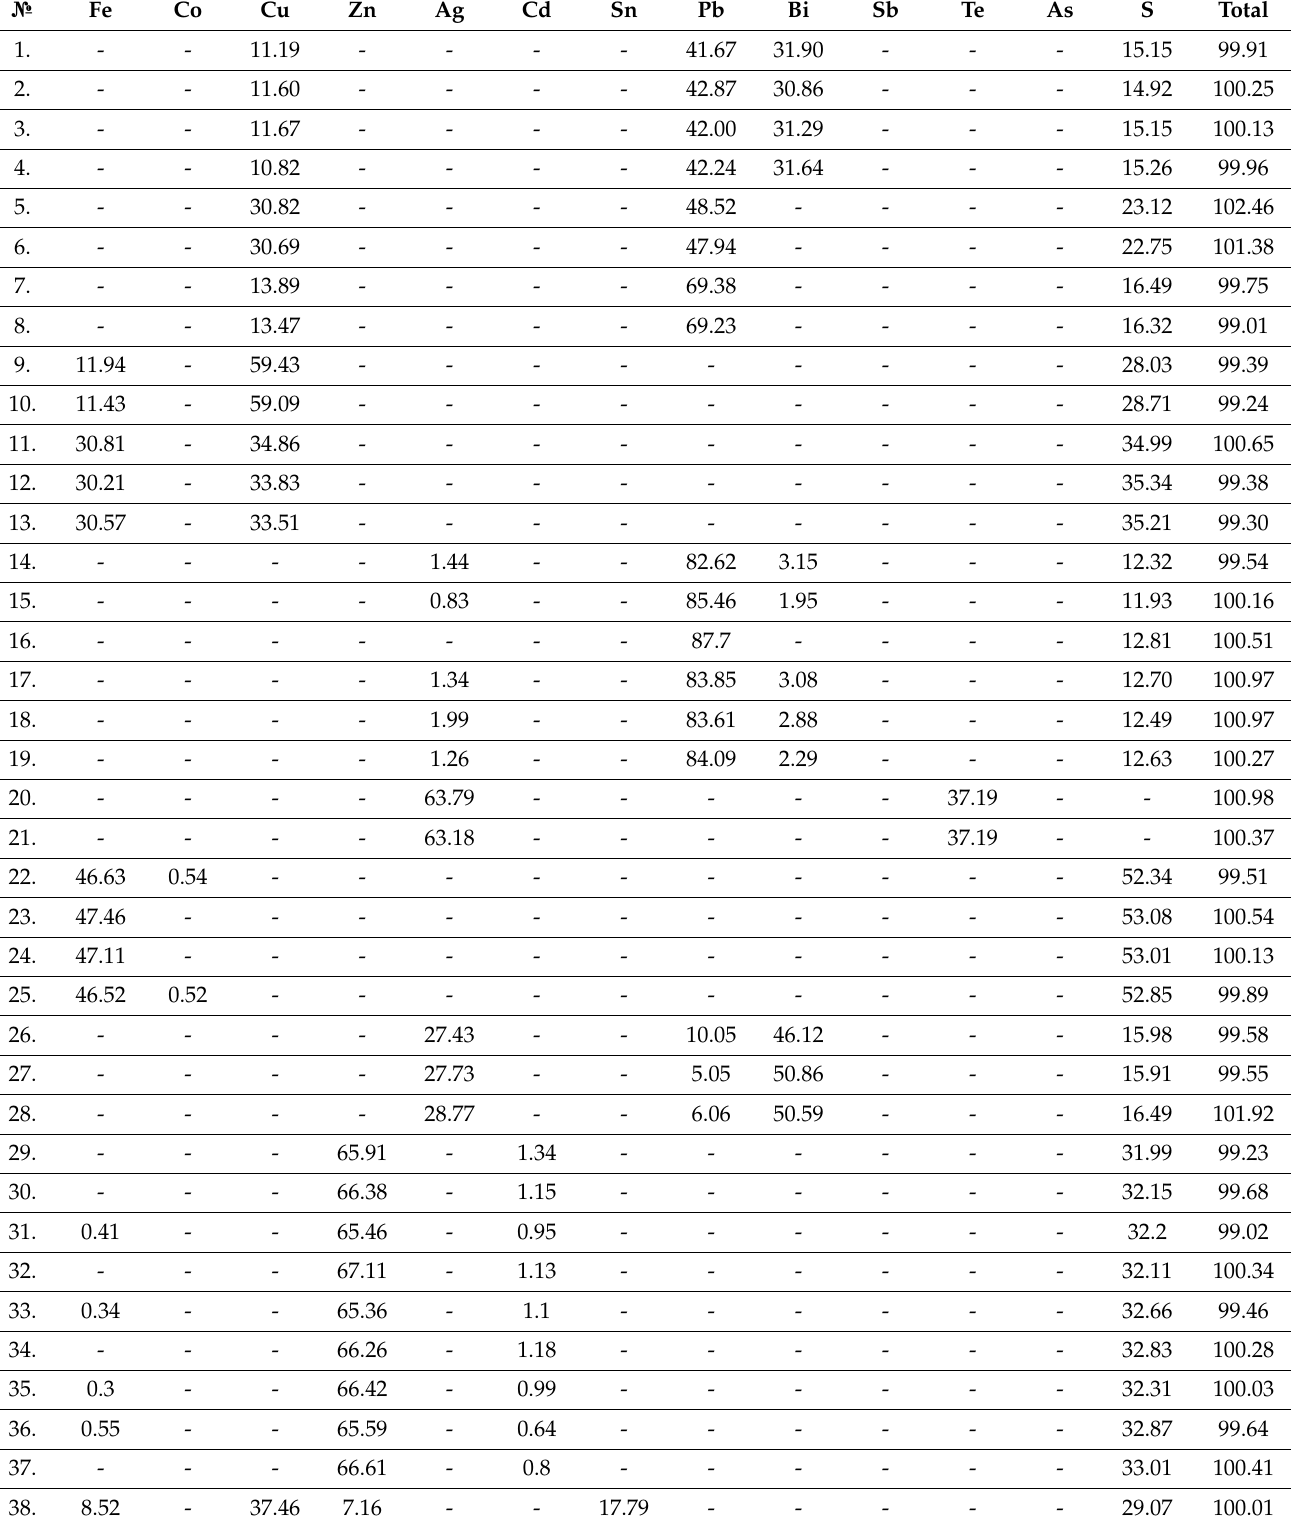
Table 5. Chemical composition of ore minerals from the Kholtoson